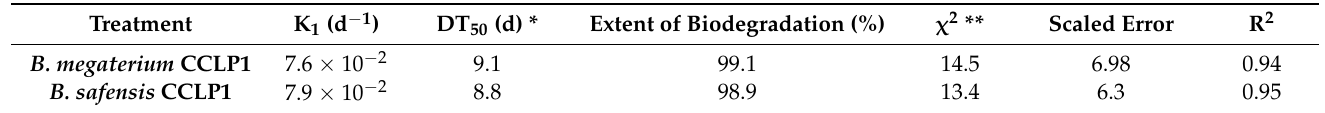
Figure 2. Chlorpyrifos biodegradation curves in solution after inoculation of B. megaterium CCLP1 ( ▲ ) or B. safensis CCLP2 ( ♦ ). Solid lines show model fitting to the experimental results (symbols). Table 3. Kinetic parameters calculated from the chlorpyrifos biodegradation curves in solution after inoculation with B. megaterium CCLP1 and B. safensis CCLP2.